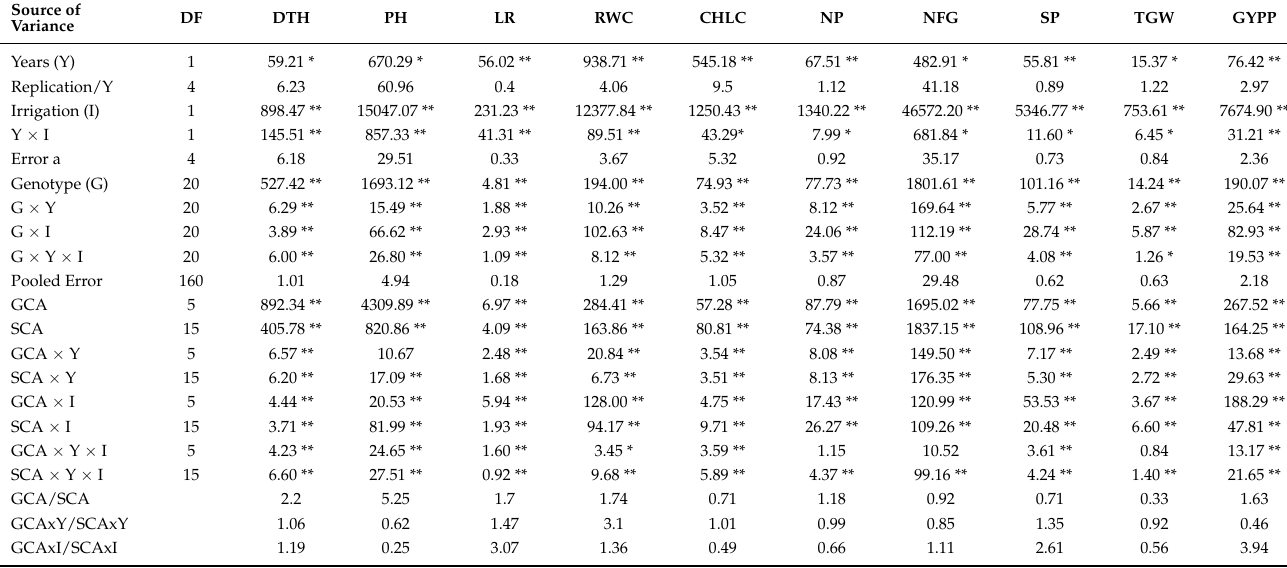
Table 2. Combined analysis of variance for all studied traits across tested